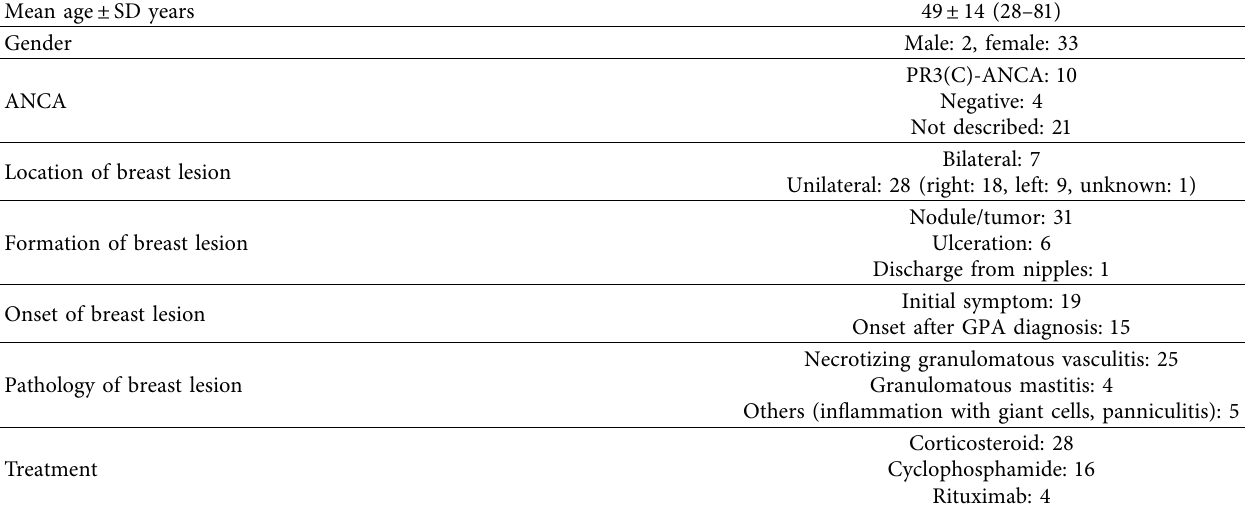
Table 1: Clinical characteristics of 35 cases of breast lesions with